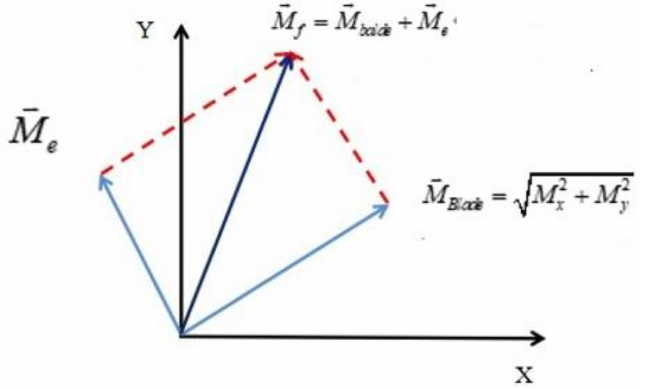
Figure 3. The initial unbalance of the disc influences optimum unbalance in the blade assembly.